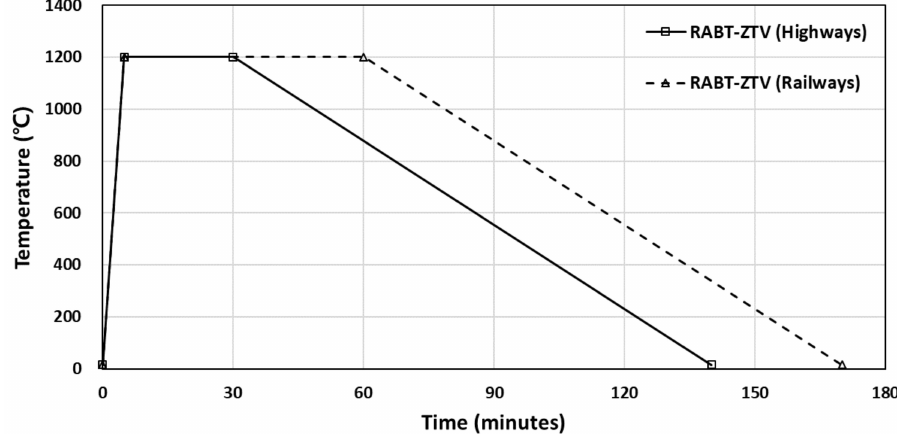
Figure 3. Richtlinien für die Ausstattung und den Betrieb von Straßentunneln (RABT) fire curves of highways and railways